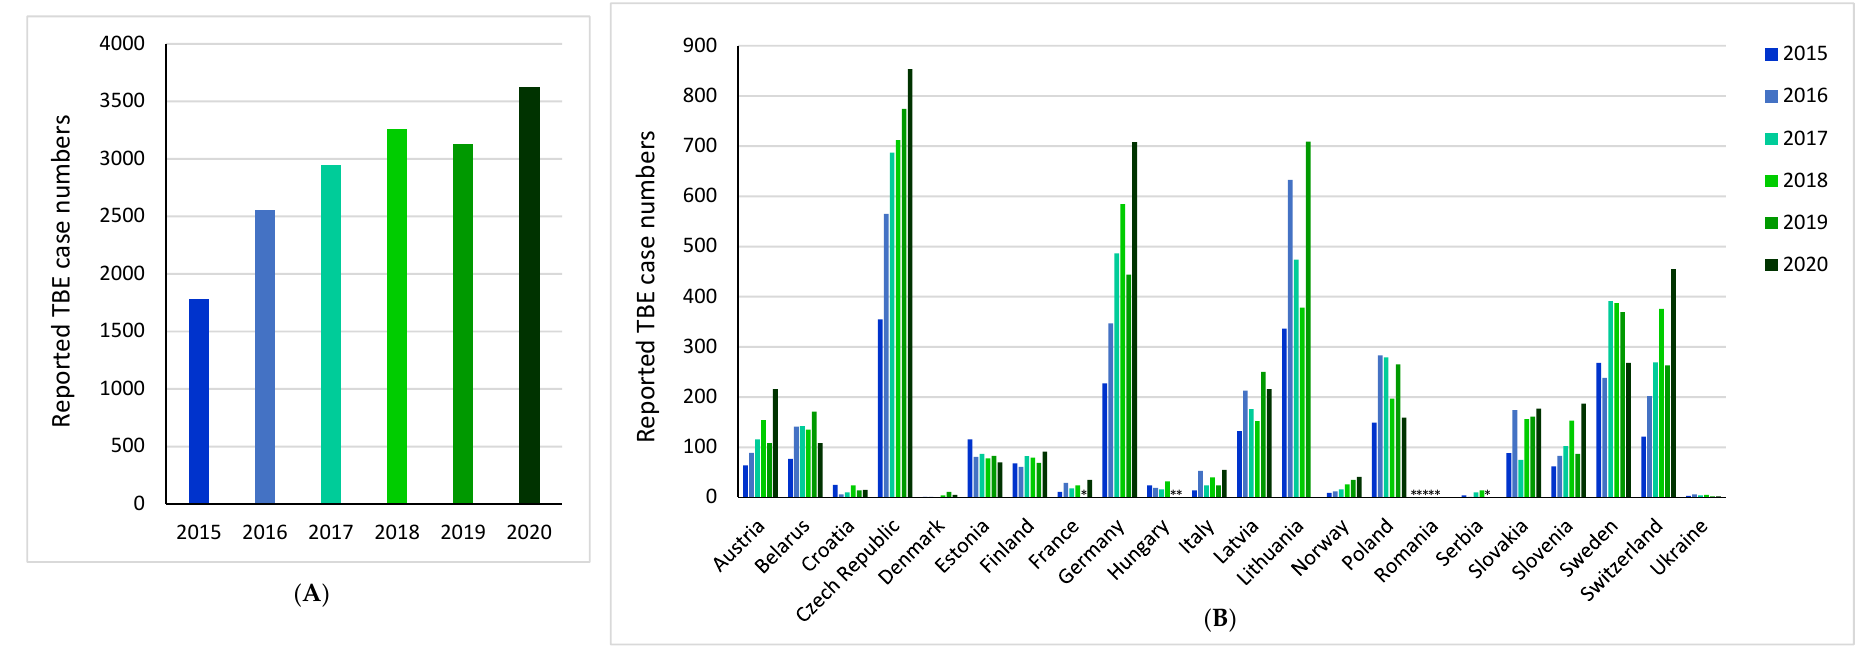
Figure 2. Reported tick-borne encephalitis (TBE) case numbers from 2015 to 2020: ( A ) across Europe; ( B ) per country. Totals calculated using countries with no missing reported TBE case data for the years 2015–2020. * Denotes missing data [10] .